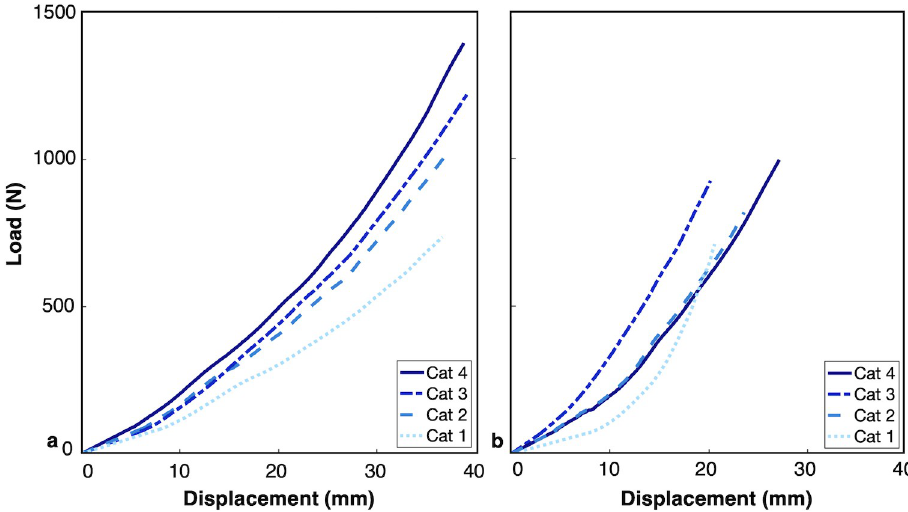
Fig 5. Illustrations of example force-displacement curves generated from mechanical testing of prosthetic foot forefeet or heels. Force-displacement plots demonstrate examples of (a) no inconsistencies observed in the order of consecutive category force-displacement curves, and (b) several inconsistencies observed between consecutive categories (e.g., cat 3 is stiffer than cat 4), multiple categories have similar data (i.e., cat 2 and cat 4), and there are differences in relative low-load to high-load stiffness behavior across categories (e.g., cat 1 compared to cat 2).